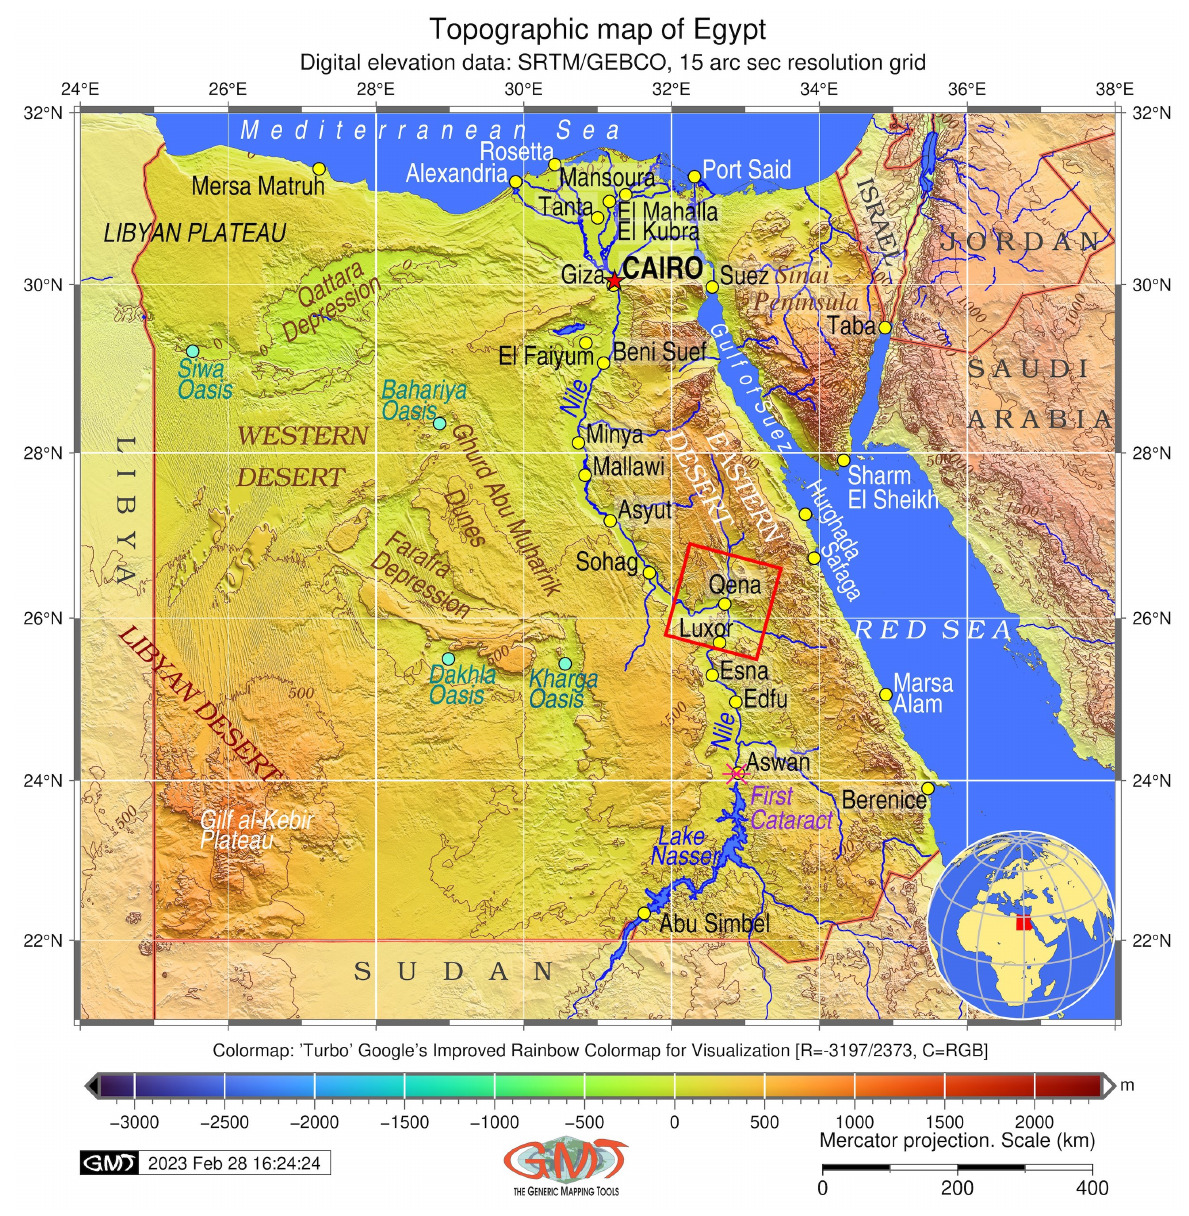
Figure 1. Topographic map of Egypt. Target study area of the Qena Bend region is shown in red rotated square. Software: GMT v. 6.1.1. Data source: GEBCO/SRTM. Cartography source: